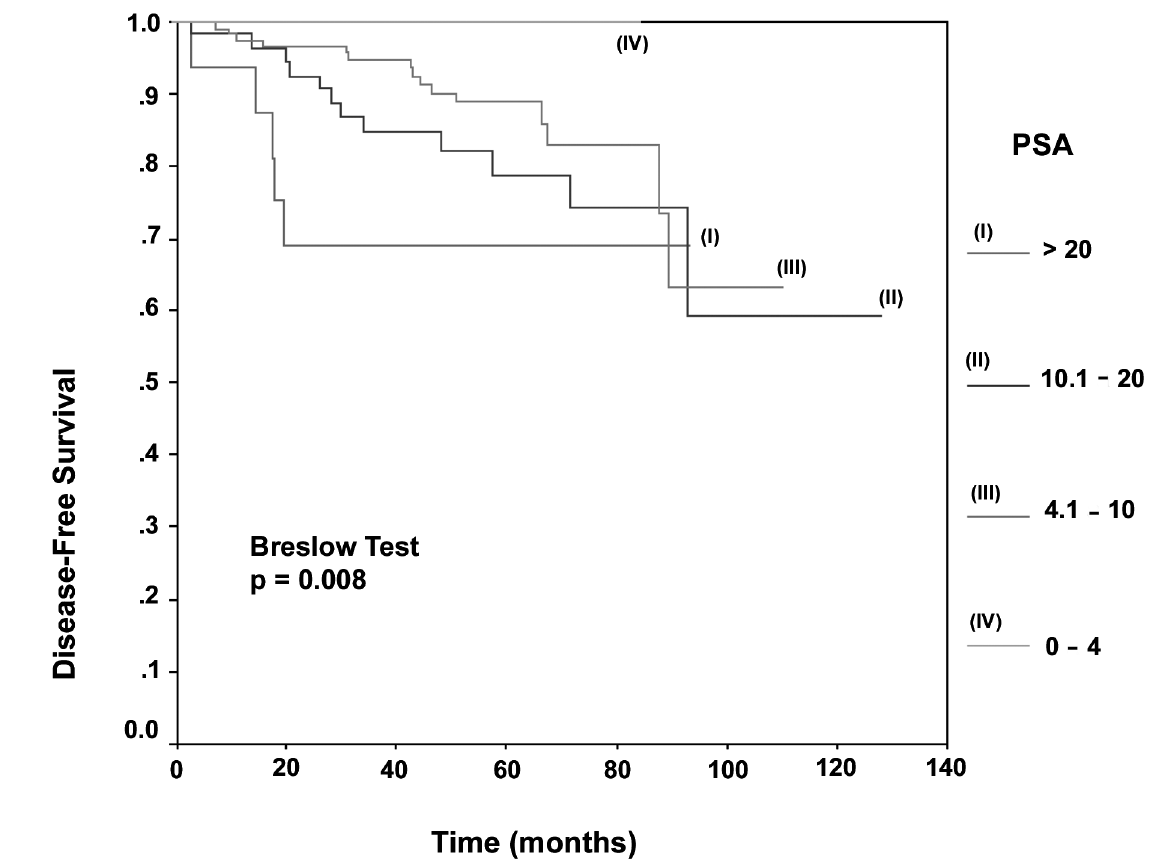
Figure 1 – Probability curve for recurrence-free survival according to PSA categories in patients with clinical stage T1c, and Gleason scores 2 -